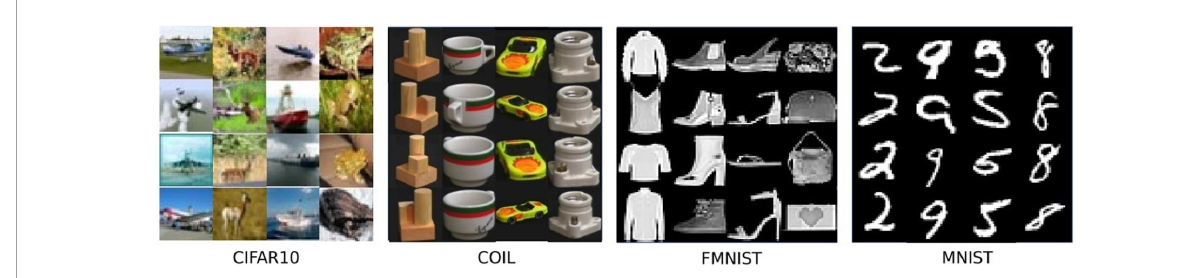
FIGURE4 Representative images from four datasets. Each column presents the same class.